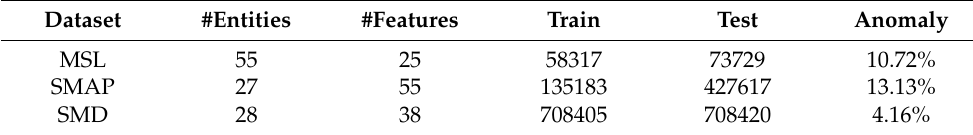
Table 1. Statistics of the